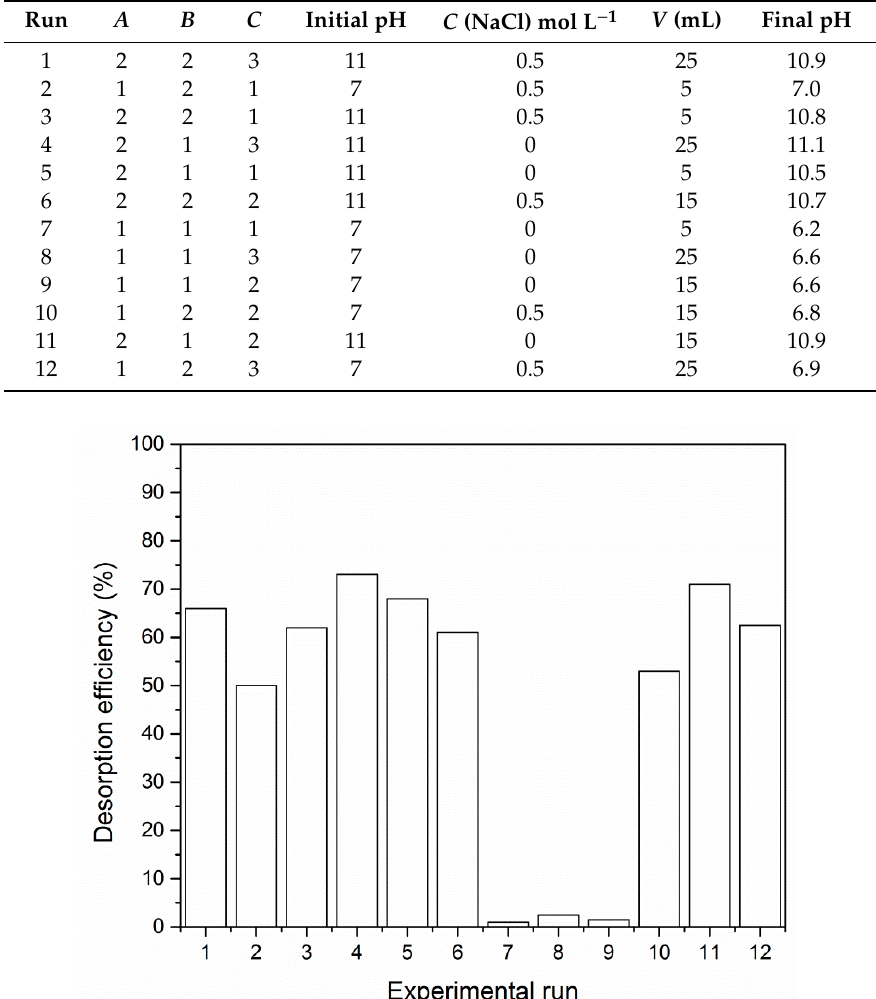
Figure 6. Desorption efficiency obtained for each experimental run (loaded adsorbent from adsorption studies after equilibration with Se, c o 5 mg L − 1 ). The experimental conditions of each run are given in Table 2.